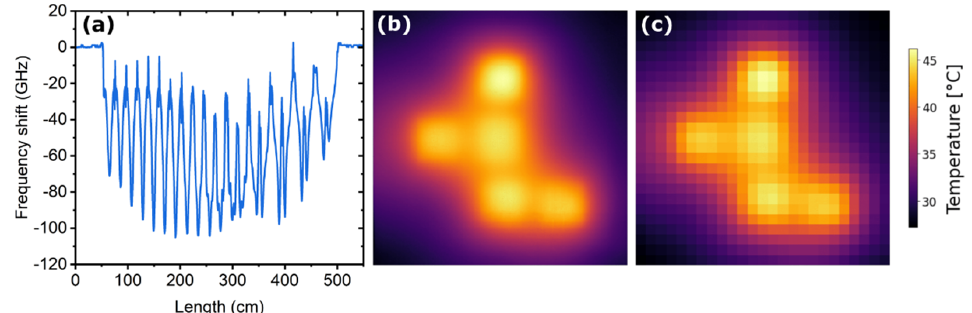
Figure 4. ( a ) Distributed spectral shift of the FUT measured by the OBR. ( b ) Original thermal image with a size of 425 × 425 pixels and ( c ) the corresponding compressed image with a size of 25 × 25 pixels.